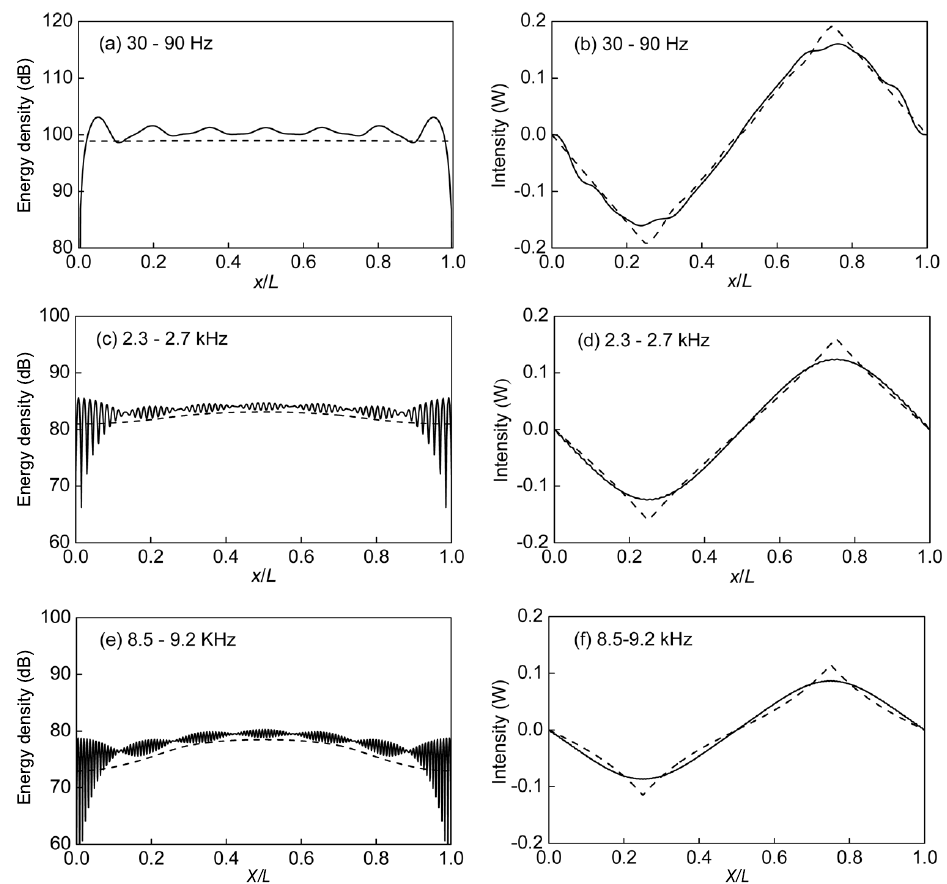
Fig. 3. Response of the beam when distributed force is applied. −− , exact solution from modal analysis; - - -, random EFA approximation. (a), (c), (e): energy density distribution in different frequency bands; (b), (d), (f) intensity in different frequency bands. The reference energy is 1 × 10 − 12 J m − 1